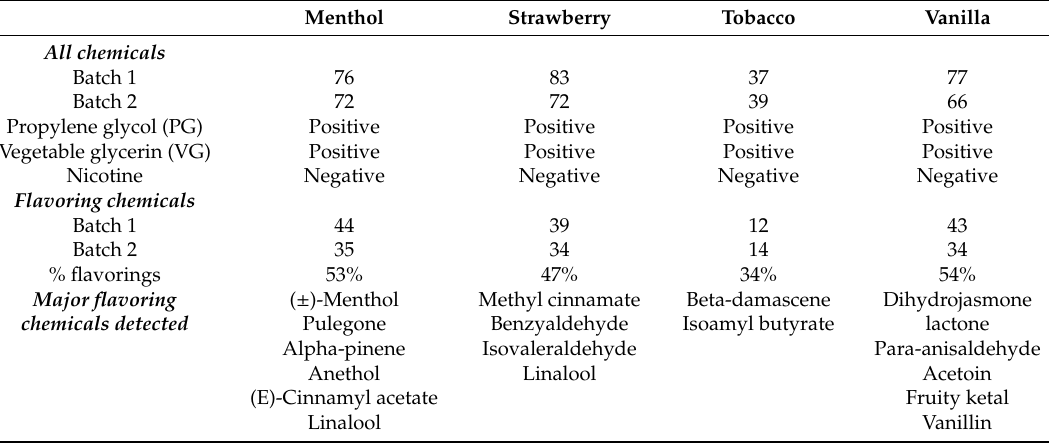
Table 1. Chemical analysis by gas chromatography–mass spectrometry (GCMS). GCMS was performed on two batches of Ecto flavoring solutions, confirming absence of nicotine but chemical variability with di ff erences in the number of chemicals present in batches of the same flavored